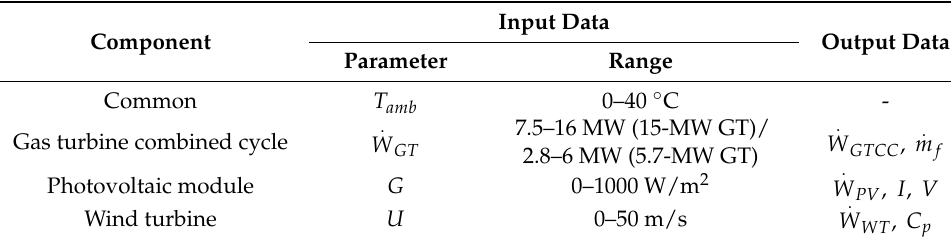
Table 6. Input and output datasets for artificial neural network